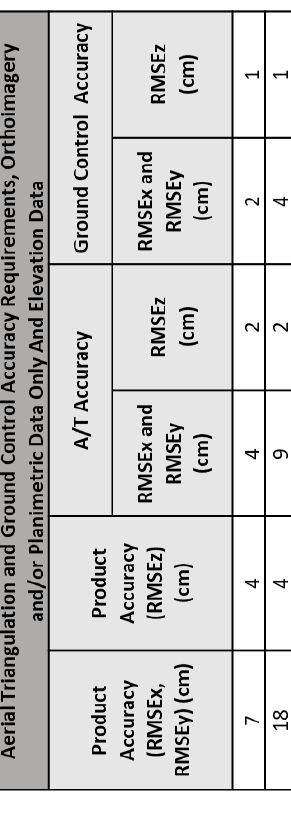
Table 8. Summary of results based on ASPRS 2014